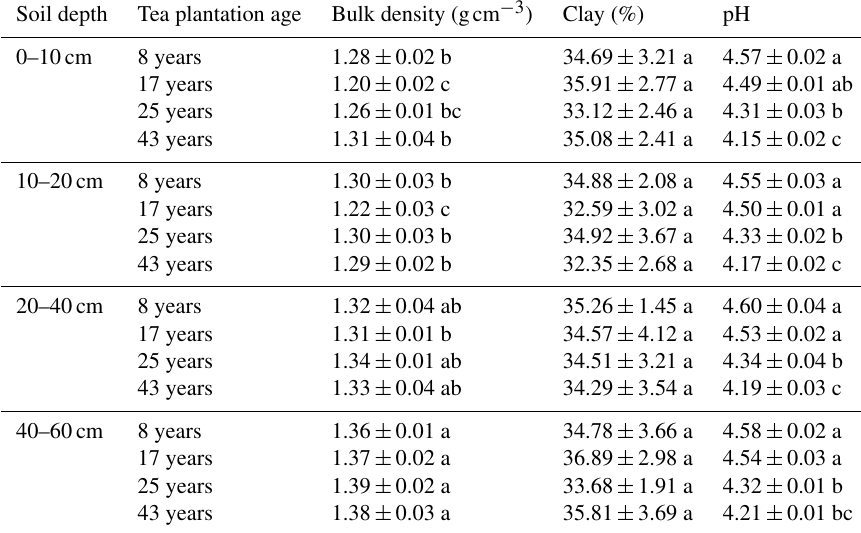
Table 2. Effects of soil depth and tea plantation age on the bulk density, clay, and pH in bulk